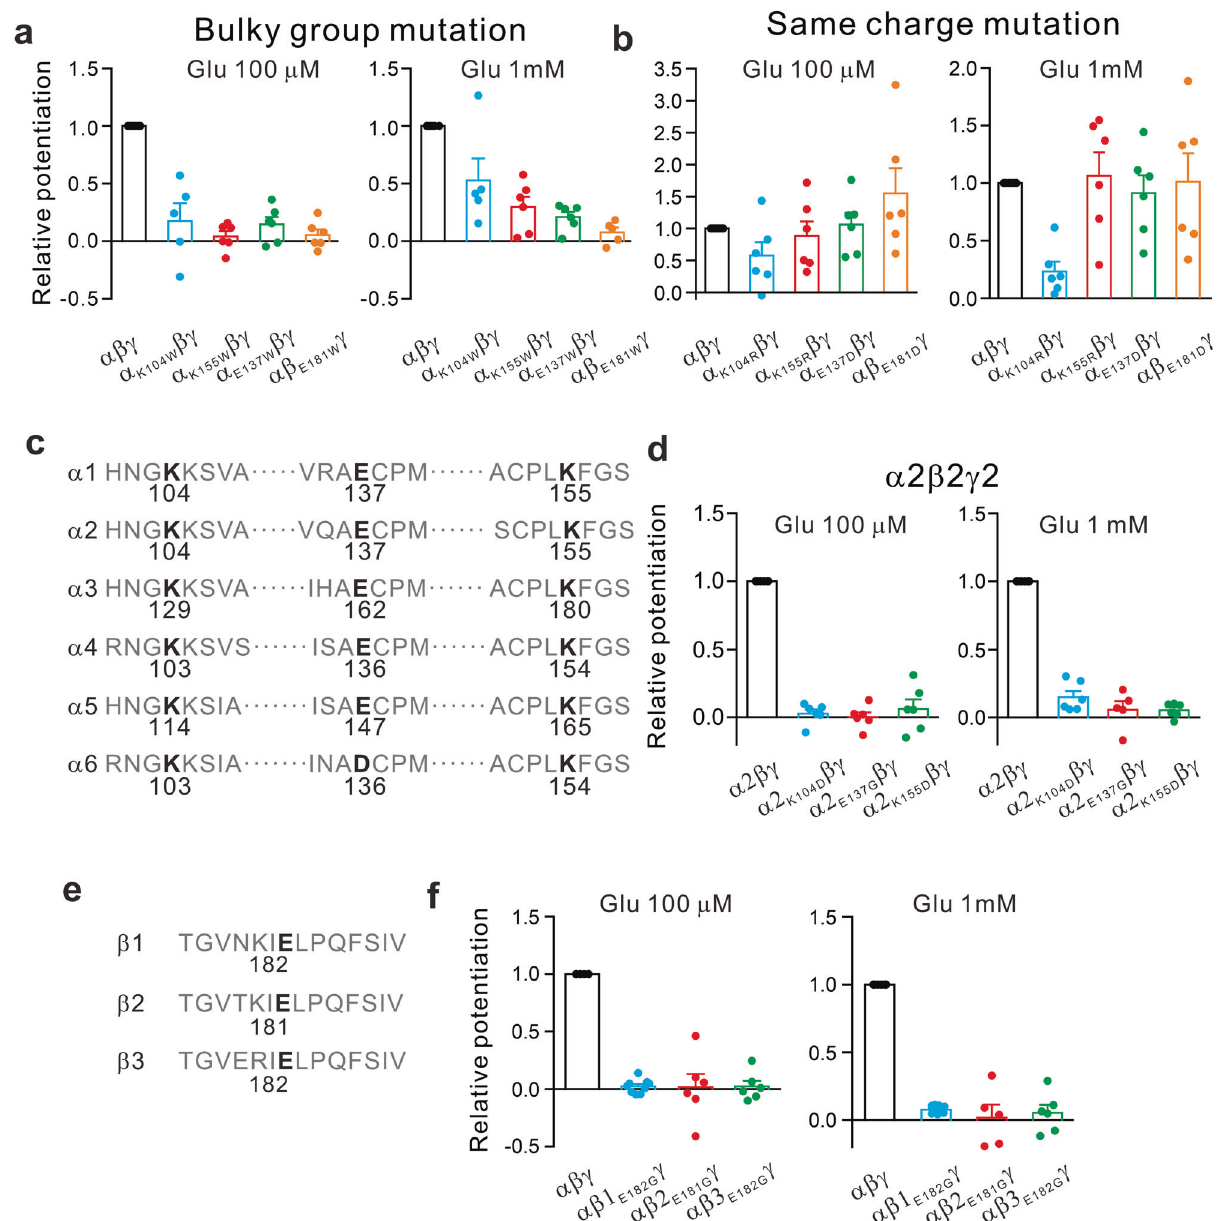
Fig. 4 Property characterization of glutamate binding sites in HEK cells expressing wild-type or mutated αβγ GABA A Rs. a , b The effects of electrostatic charge and/or size of the pocket-forming residues on glutamate-induced functional modulation. Substitution of the residue α 1 α 1 β 2 α 1 K104 , K155 , E137 , or E181 with non-charged, bulky tryptophan (W) residue impaired glutamate-mediated potentiation ( a ; n each group), whereas mutation of these residues into a different residue with the same charge (except for the K-R mutation) had little effect on the potentiation ( b ; n = 5 or 6 in each group). c , d Residues critical for glutamate binding pocket in α 1 are conserved among all α subunits. Sequence alignment showed that α 1 K104 , α 1 K155 , and α 1 E137 are conserved in all six α subunits ( d ), and mutating either of these